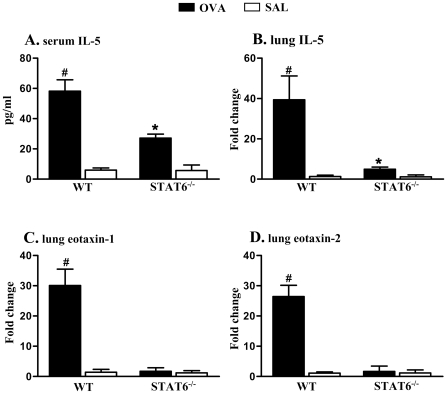
The levels of IL-5 in serum and expression of eotaxin-1 and -2 mRNA in lungs.OVA/OVA treated WT mice had significantly increased levels of (A) serum IL-5 and mRNA encoding (B) IL-5, (C) eotaxin-1 and (D) eotaxin-2 in lung tissue compared to SAL/OVA treated controls. OVA/OVA treated STAT6-deficient mice also had significantly increased levels of IL-5 in serum and lung but these levels were lower than OVA/OVA treated WT mice. There was no increase the expression of eotaxin-1 and -2 in OVA/OVA treated STAT-6 deficient or SAL/OVA treated controls. #P<0.05 compared to other groups. *P<0.05 compared to respective SAL/OVA treated control.